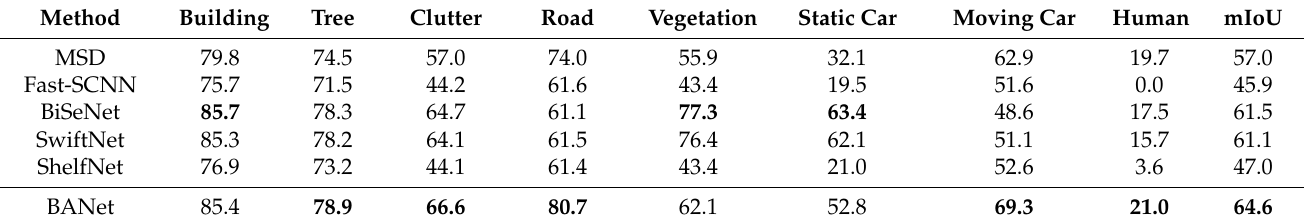
Figure 11. The experimental results on the UAVid test set. The first column illustrates the input RGB images; the second column depicts the outputs of MSD, and the third column shows the predictions of our BANet. Table 3. The experimental results on the UAVid dataset.